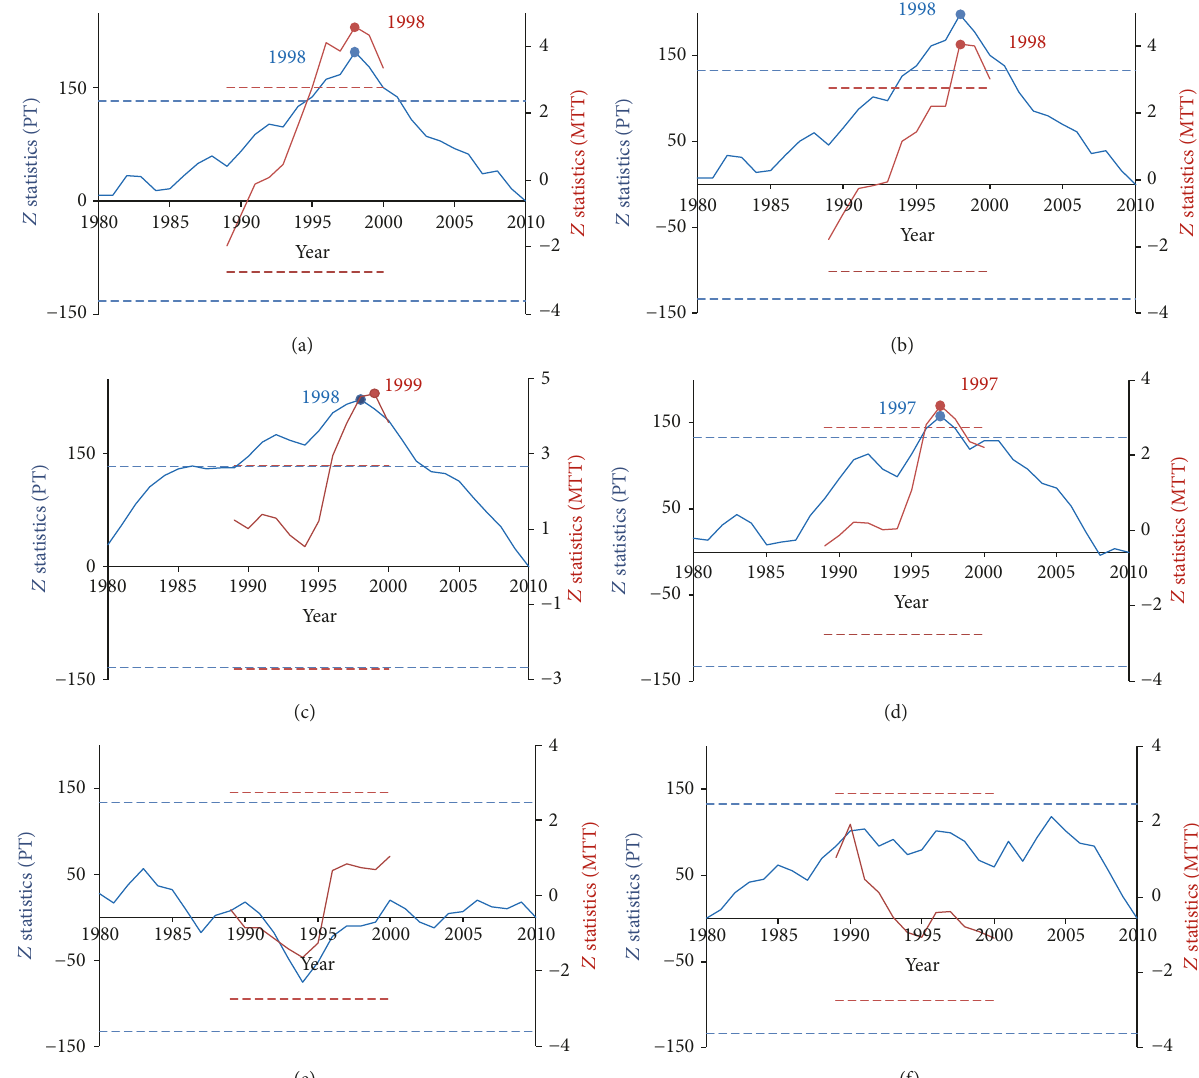
Figure 4: The identification of the abrupt change point of runoff in the six mountainous subbasins. The blue and red dots represent the abrupt change point of runoff obtained by a Pettitt test (PT) and moving 𝑡 -test (MTT), respectively. The blue and red lines represent the statistical values obtained by the method of PT and MTT, respectively. The dashed lines represent a significance level of 0.01. (a) is Luan River Basin (LRB), (b) is Chaobai River Basin (CRB), (c) is Yongding River Basin (YRB), (d) is Daqing River Basin (DRB), (e) is Ziya River Basin (ZRB), and (f) is Zhang River Basin